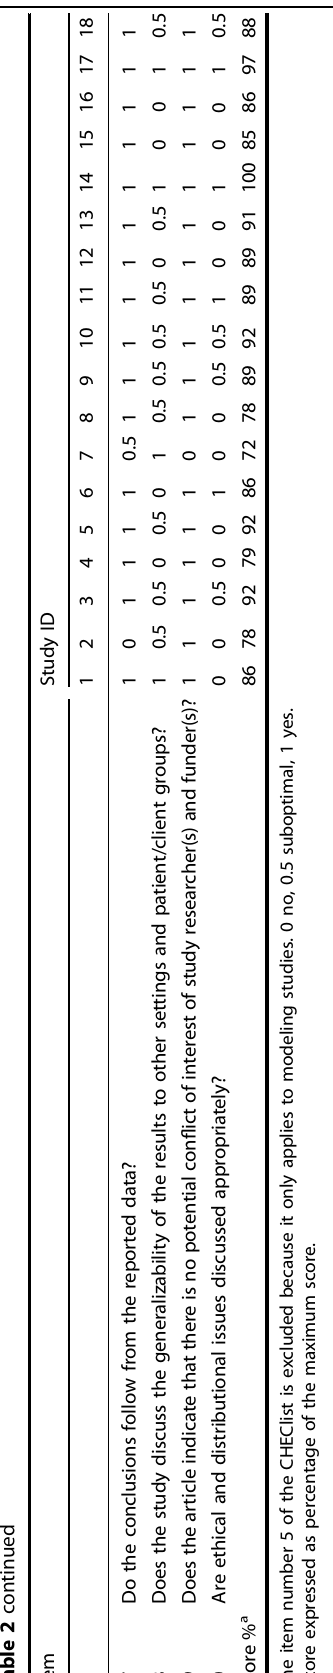
stress levels ( n = 2), posttraumatic stress disorder (PTSD, n = 1), and suicidal ideation ( n = 1). Most studies evaluated guided ( n = 21) or unguided ( n = 9) interventions, and only two evaluated